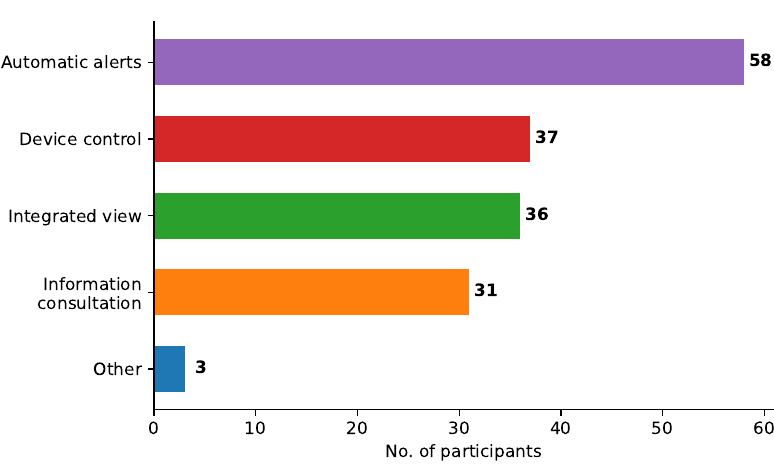
Figure 5. Results for the question on the most useful assistant’s functionalities.